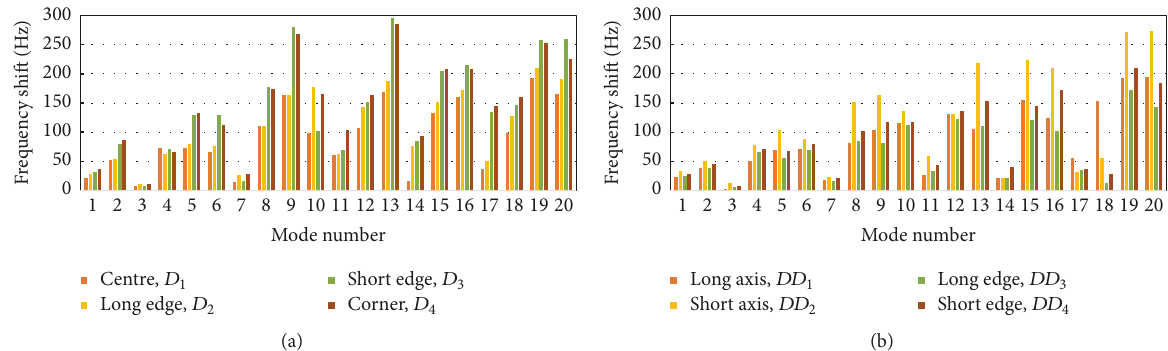
Figure 17: Natural frequency shifting for the debonded sandwich plate depending on location of the following: (a) single debonding and (b) two equally sized debondings.